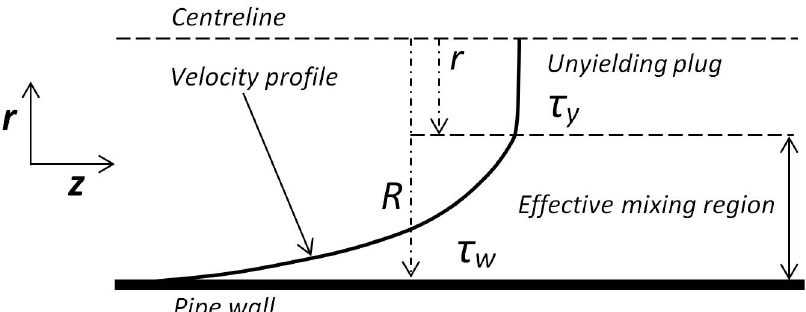
Figure 4. The effective mixing region in a pipe carrying a Herschel–Bulkley fluid with yield stress τ y . The unyielding plug represents the region wherein τ < τ y